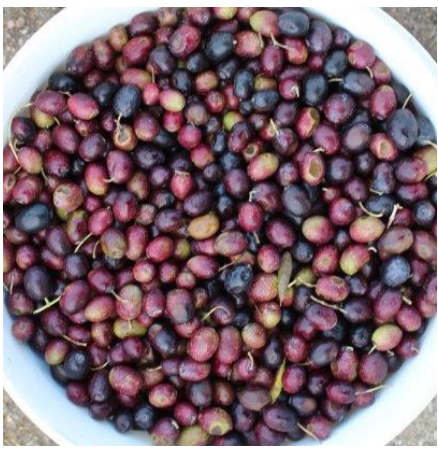
Figure 2. Drupes used in the pitting tests of the final prototype.